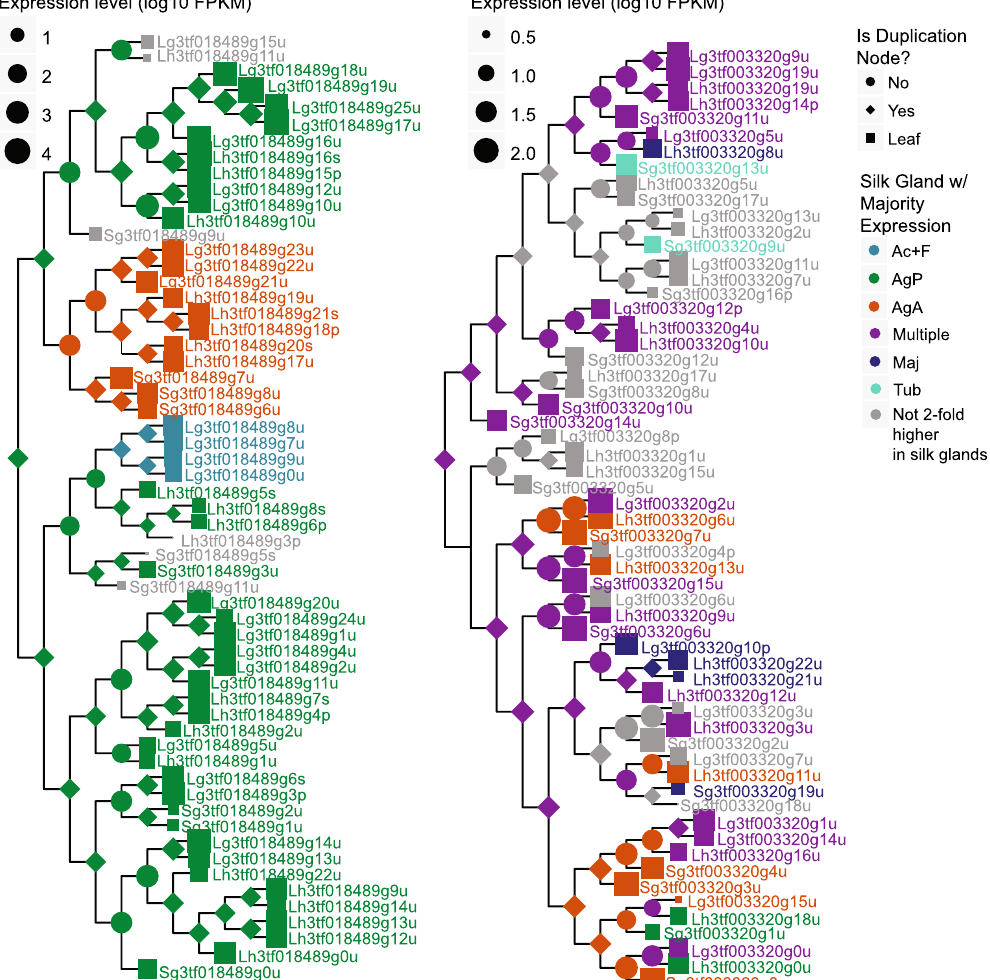
Figure 7. Exemplar gene trees demonstrate the reconstruction of ancestral expression states. Left tree contains homologs of the PXCC family of proteins, which are highly expressed in venom glands of spitting spiders 64 . Transcripts in the right tree encode homologs of transmembrane transport proteins. Branch lengths are ultrametric. For branch lengths reflecting molecular distances see Supplementary File 5. Horizontal width of symbols represents expression